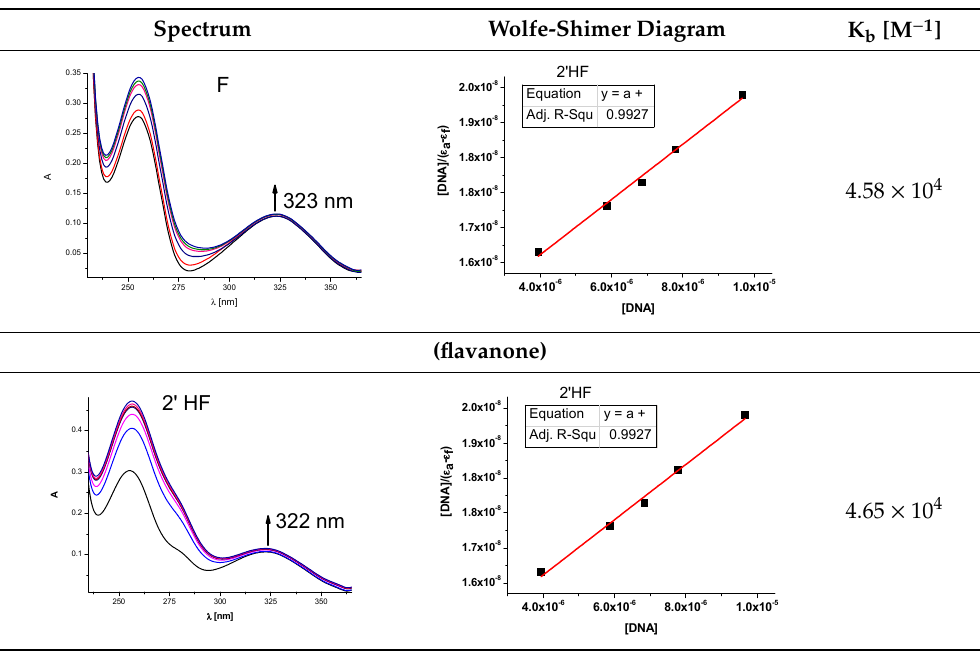
Table 6. Spectra, K b DNA intrinsic binding constants and the Wolfe-Shimer diagrams of flavanones (The plots were prepared with Origin(Pro) software using the original files from the instrument: Perkin-Elmer Lambda 11 spectrophotometer). Concentration of CT DNA (Tris) from 1.91 to 6.58 μ M for 6HF, 2.3 to 33.2 μ M for 7HF, and 4 to 10 μ M for F and 2’HF.